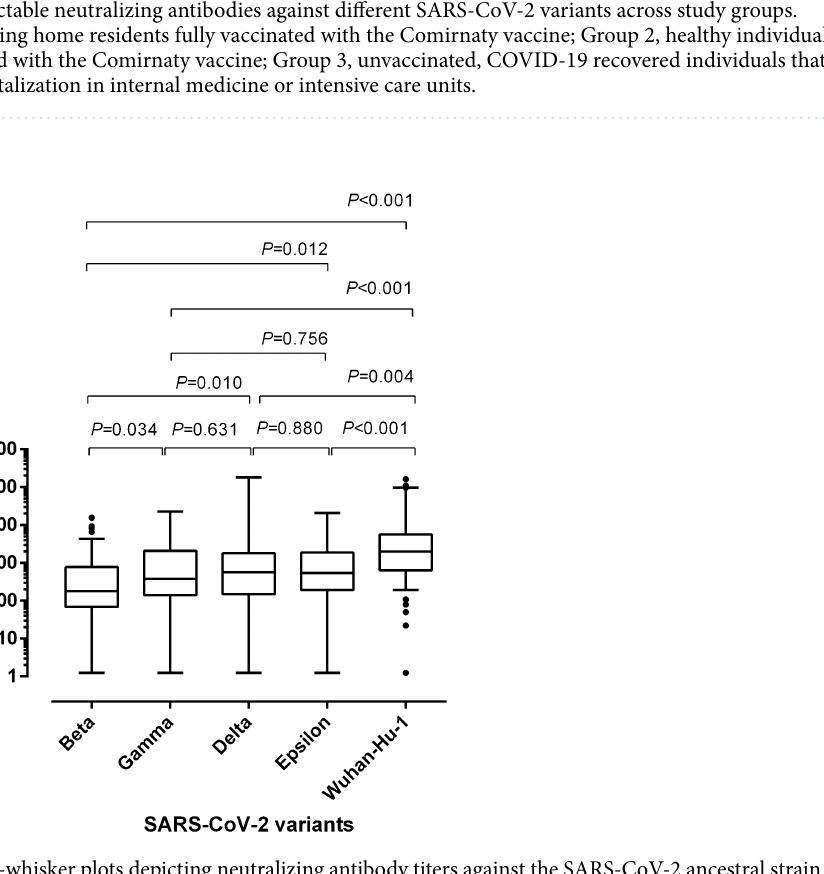
Figure 2. Box-whisker plots depicting neutralizing antibody titers against the SARS-CoV-2 ancestral strain (Wuhan-Hu-1) and variants of concern Beta, Gamma, Delta and Epsilon in sera form participants. P values for pairwise comparisons are